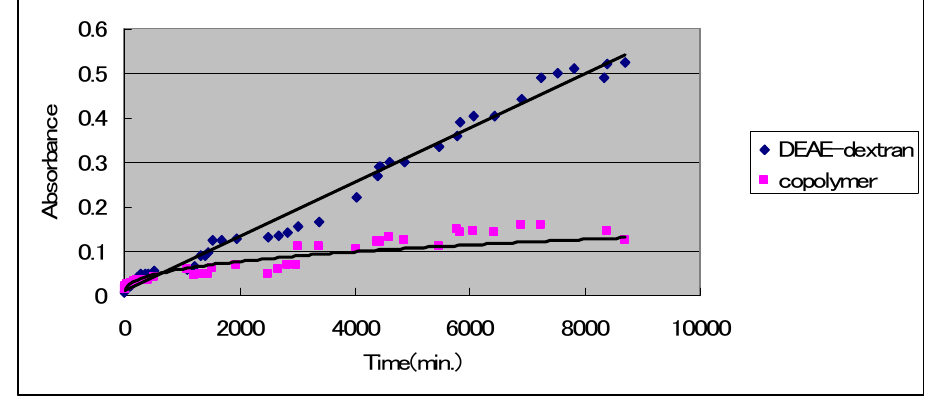
Figure 2. DNase degradation times for foreign DNA complex with DEAE-dextran-MMA graft copolymer and DEAE-dextran, respectively. DNase I degrades both double-stranded and single-stranded DNA endonucleolytically, producing 3´-OH oligonucleotides. Toluidine Blue (TB) is isolated in water from DNA after the degradation, as the DNA is stained with TB. This shows the absorbance of TB isolated from DNA in each sample in the water with a